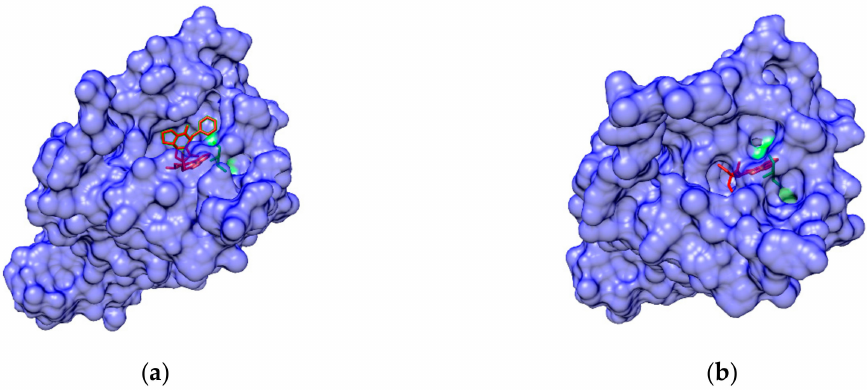
Figure 4. The binding pocket of 5-HT 2B is ( a ) open when ergotamine binds and is ( b ) partially closed by movement of L209 EL2 when LSD binds.